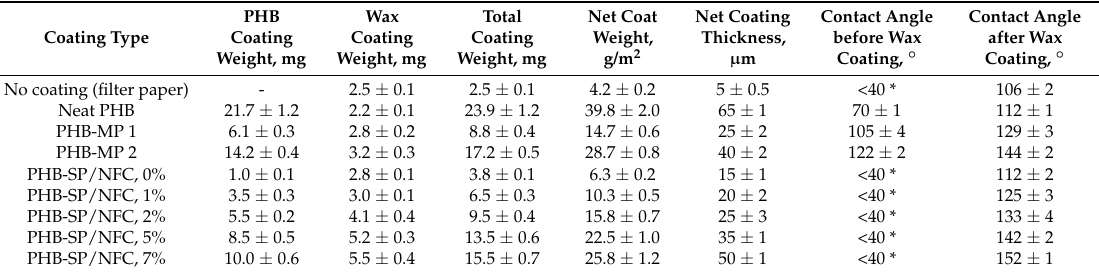
Table 1. One-sided coating weight and thickness for PHB-MP- and PHB-SP/NFC-coated papers, along with the summary of corresponding contact angle